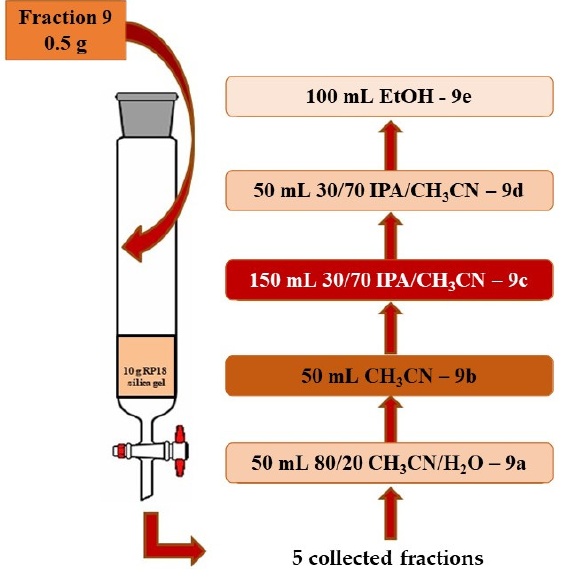
Figure 2. Selective extraction of carotenoids by RP-C18-SPE of fraction 9.